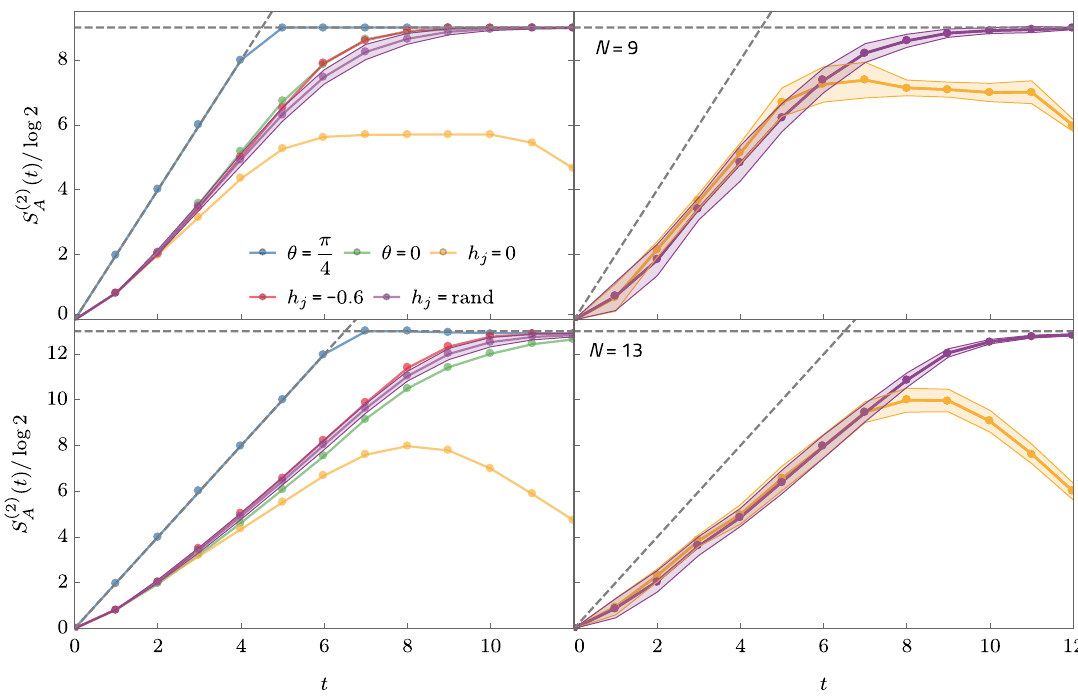
FIG. 7. The second R´enyi entropy for a kicked Ising system of L ¼ 30 spins evolving from “ tilted ” initial states (12). Top and bottom two panels have, respectively, N ¼ 9 and N ¼ 13 . The two panels on the left report results for translational-invariant initial states. The blue and green curves correspond, respectively, to transverse and longitudinal separating states [cf. Eqs. (17) and (18)]. Other curves ϕ 1 and different magnetic fields as indicated in the legend. The two panels on the right correspond to the initial state θ j ¼ j ¼ correspond to the maximally disordered cases, where the spins at each site point in a random direction, and the magnetic fields h either random (purple) or zero (yellow). In the cases with random parameters, we show the average values for a sample of eight realizations using a continuous line and indicate a standard deviation of one realization by a shaded area.